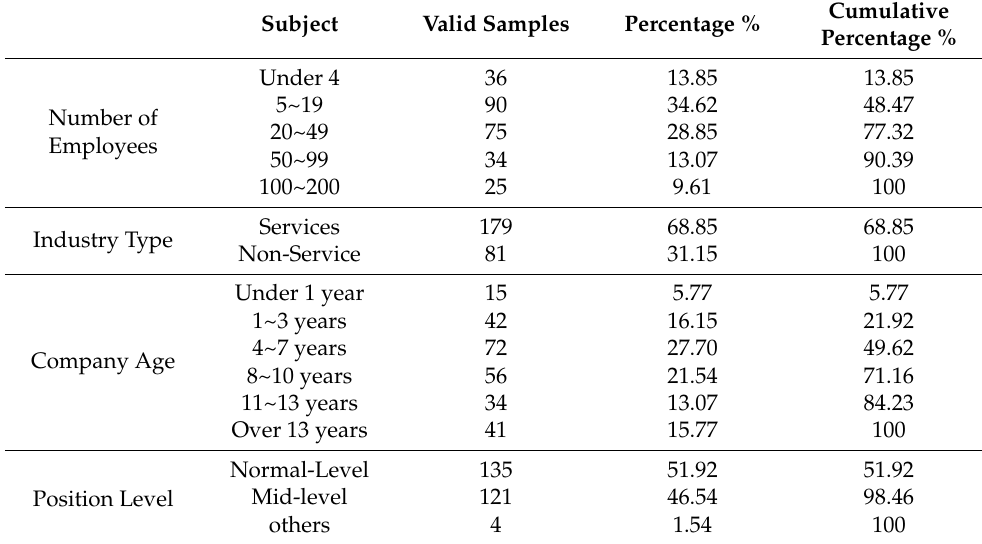
Table A4. Sample characteristics.